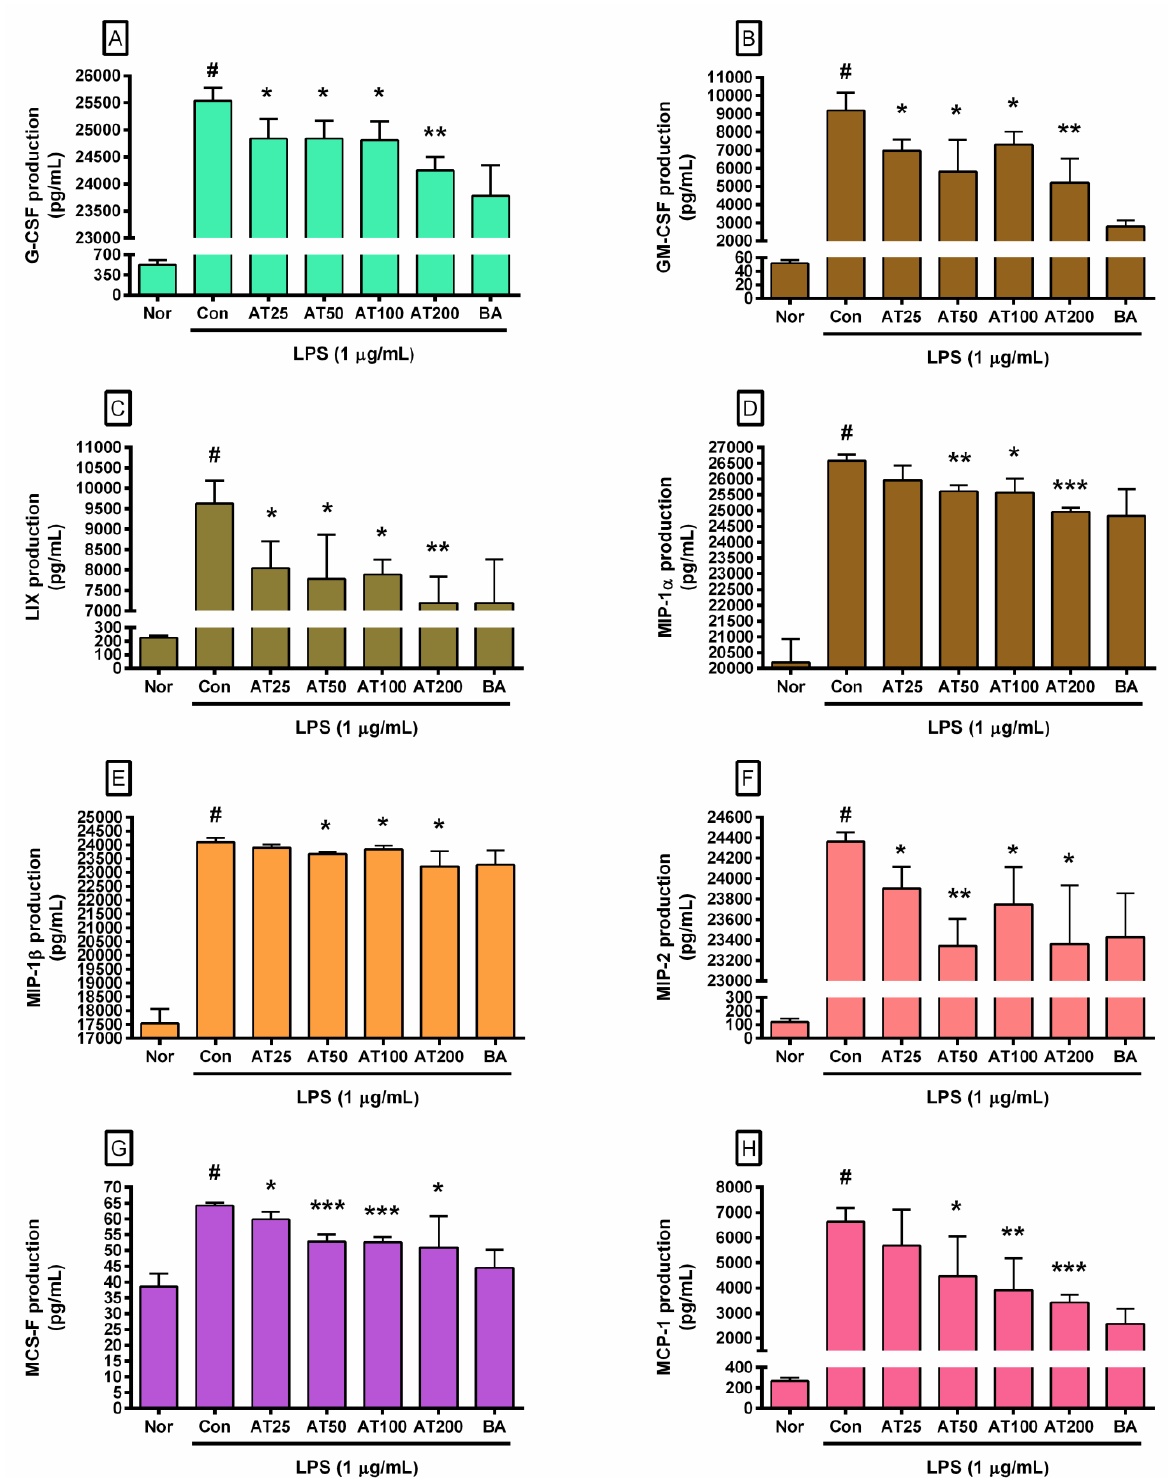
Figure 3. Production of G-CSF ( A ), GM-CSF ( B ), LIX ( C ), MIP-1 α ( D ), MIP-1 β ( E ), MIP-2 ( F ), M-CSF ( G ), and MCP-1 ( H ) in RAW 264.7 activated by LPS. Values are presented as mean ± SD. Nor, the group treated with cell culture media alone; Con, the group treated with lipopolysaccharide (LPS, 1 µ g/mL) alone. AT25 means 25 µ g/mL of AT, AT50 means 50 µ g/mL of AT, AT100 means 100 µ g/mL of AT, and AT200 means 200 µ g/mL of AT. BA, baicalein (25 µ M). #, p < 0.05 vs. Nor; *, p < 0.05 vs. Con; **, p < 0.01 vs. Con; ***, p < 0.001 vs.